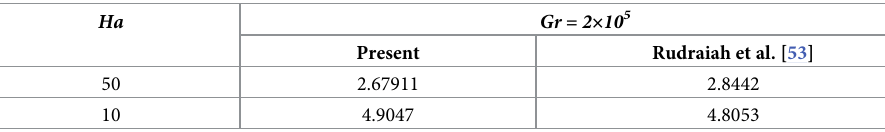
with varying Ha at Pr = ave